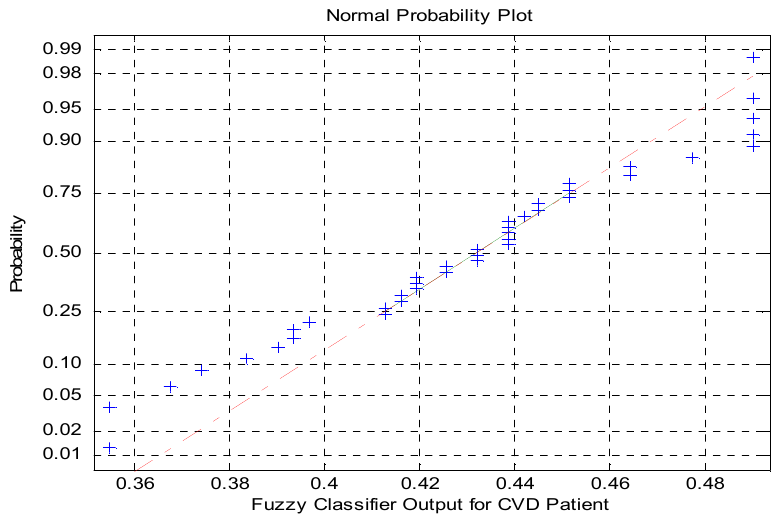
Figure 4. Normal probability plot for the fuzzy modeled output.